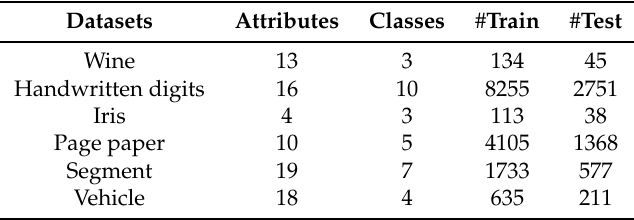
Table 3. Parameters of the classification dataset.